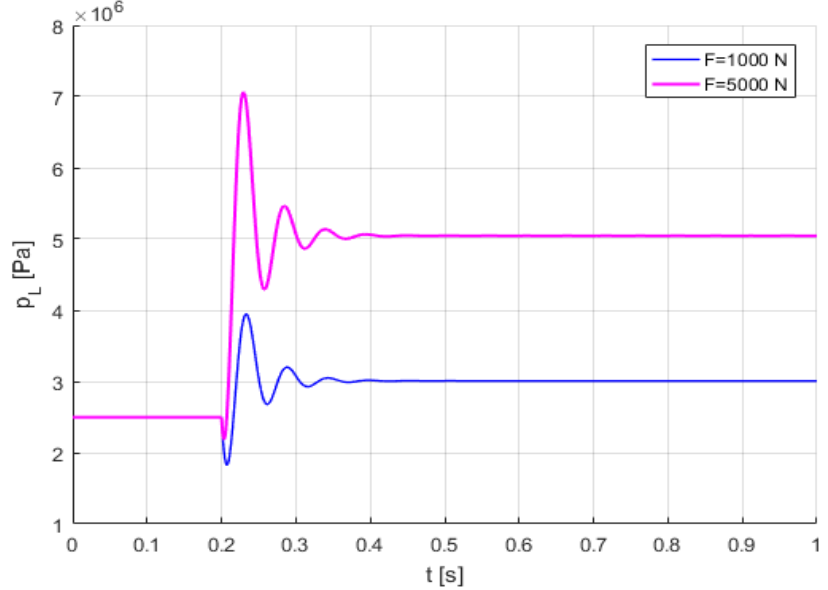
Figure 14. Comparison of the dynamic responses of the shock pressure p L ( t ) of an SHA damped by